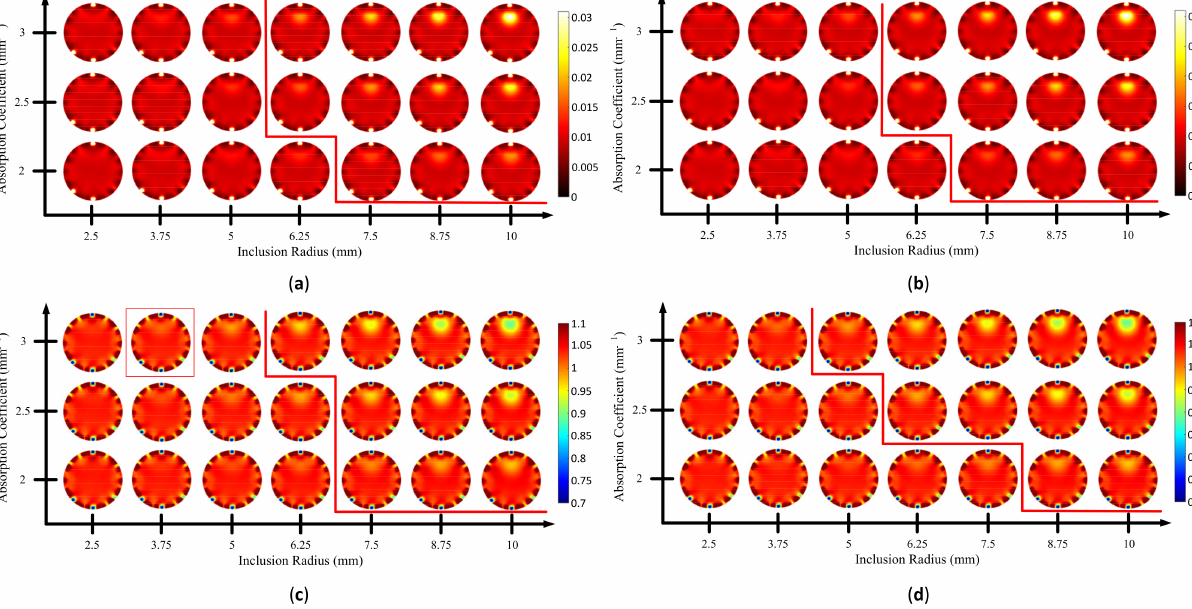
Figure 19. Reconstructed images of case B2 with 1% noise amplitude; red line indicates the invisible ( left side ) and visible ( right side ) inclusions: ( a ) µ a MS-ISSIM-S, ( b ) µ a MOS, ( c ) µ (cid:48) s MS-ISSIM-S, and ( d ) µ (cid:48) s